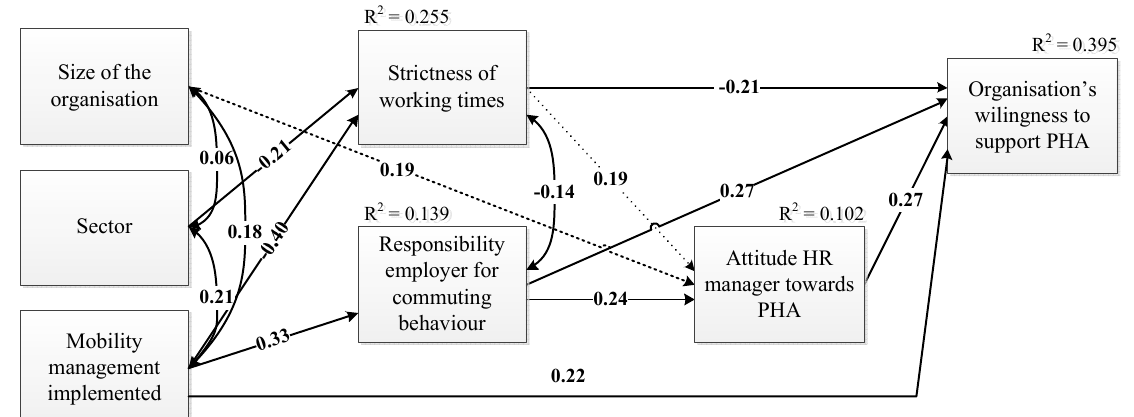
Figure 1. Path diagram of the estimated structural model - Dotted arrow indicates a significant effect at the 0.1